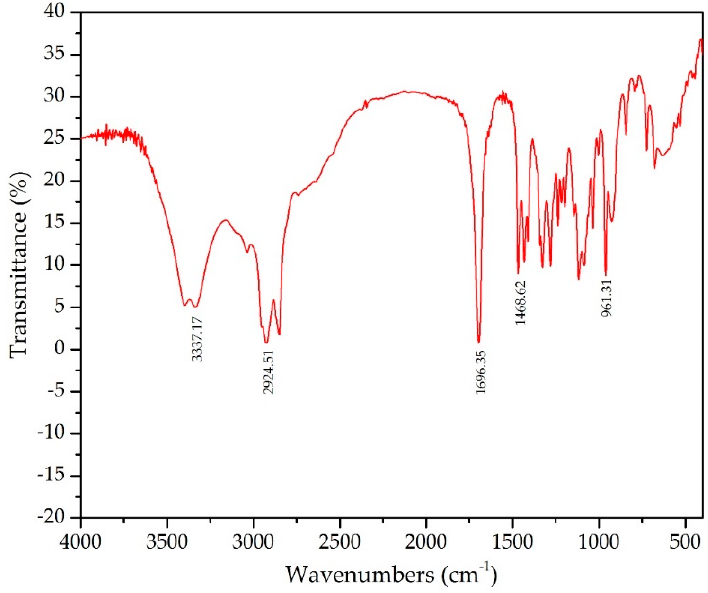
Figure 1. FTIR spectra of the product produced from olive oil by Pseudomonas aeruginosa PR3.